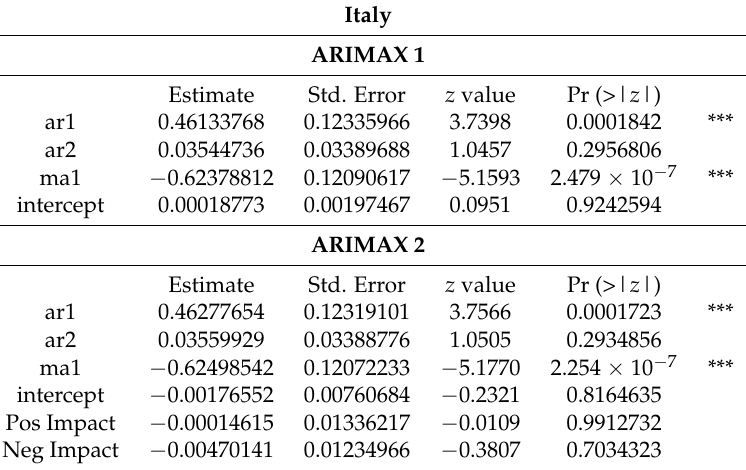
Table 17. z -test of coefficients for ARIMAX models in Italy for first difference of mean country